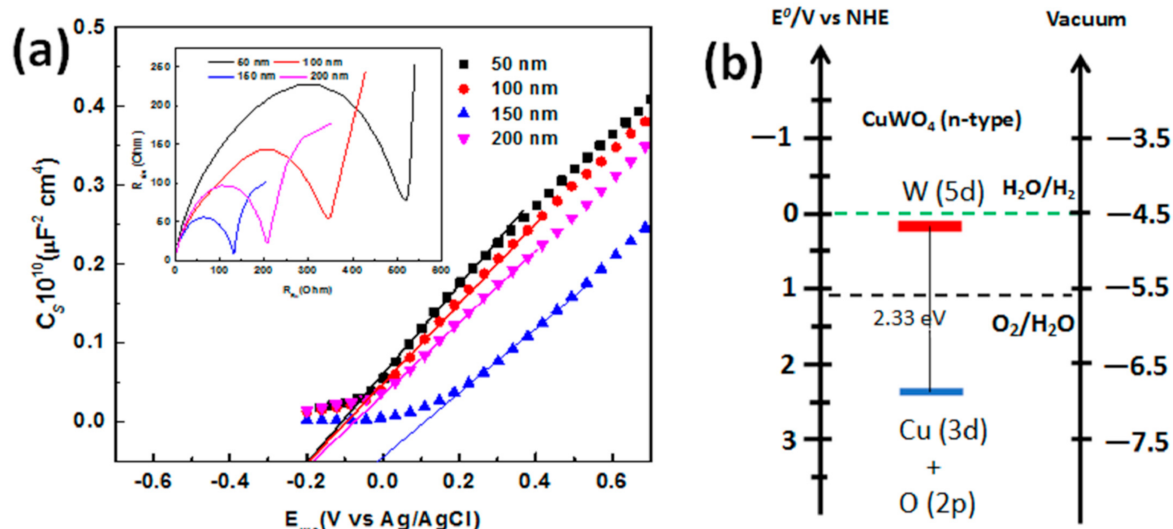
Figure 6. ( a ) The Mott-Schottky plot used to determine the direct voltage of the flat band for each of the photoanode of the CuWO 4 nanorod arrays (the smaller image shows the SPEIS measurement for the Nyquist plot) and ( b ) the energy level scheme of the photoanode of the CuWO 4 nanorod